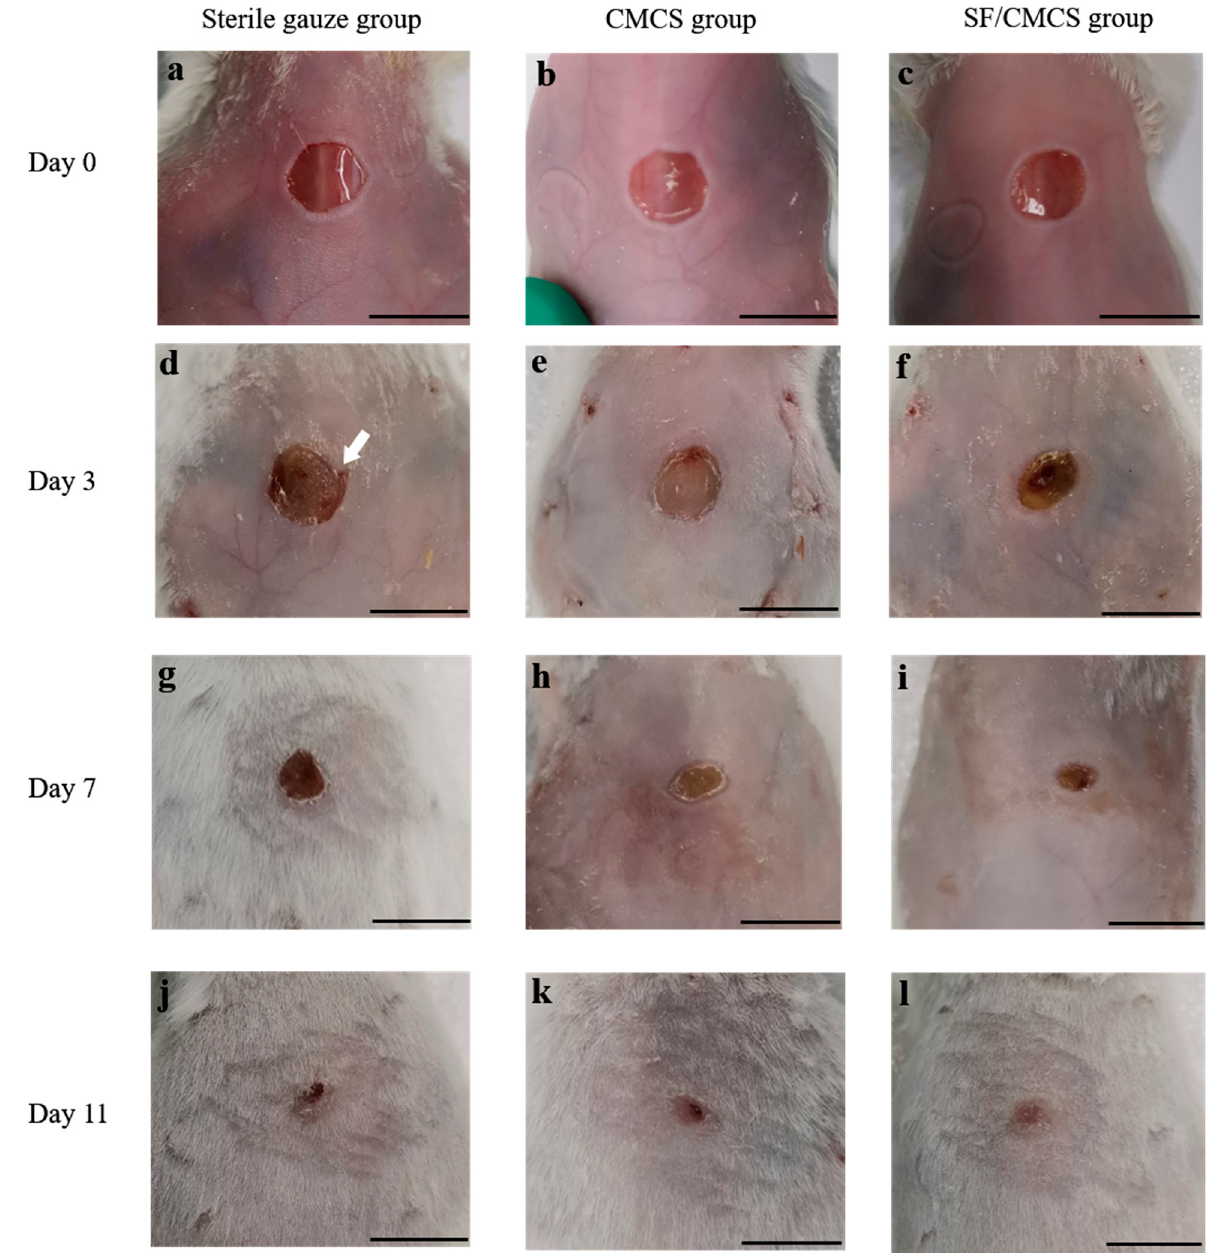
Figure 10. Wound healing of the sterile gauze group, CMCS group, and SF/CMCS group. ( a , d , g , j ) are the gross observations of wounds treated by sterile gauze at the 0th, 3rd, 7th, and 11th days, respectively. ( b , e , h , k ) are the gross observations of wounds treated by CMCS hydrogels at the 0th, 3rd, 7th, and 11th days, respectively. ( c , f , i , l ) are the gross observations of wounds treated by SF/CMCS hydrogels at the 0th, 3rd, 7th, and 11th days, respectively (scale bar: 1 cm). On the basis of hematoxylin and eosin (H&E) stained slides, the length of the newly formed epithelium was measured using ImageJ software (ImageJ 1.6.0) and is indicated by green arrows in Figure 11a. As shown in Figure 11a,b, on the third day after surgery, the length of the newly formed epithelium in the SF/CMCS group (466.61 ± 23.99 µm) was longer than those in the CMCS group (342.56 ± 18.86 µm) and the sterile gauze group (201.27 ± 40.58 µm). The groups showed a similar tendency on the 7th day, with a length of 953.73 ± 36.76 µ m for the SF/CMCS group, 795.22 ± 17.80 µ m for the CMCS group, and 793.16 ± 16.27 µ m for the sterile gauze